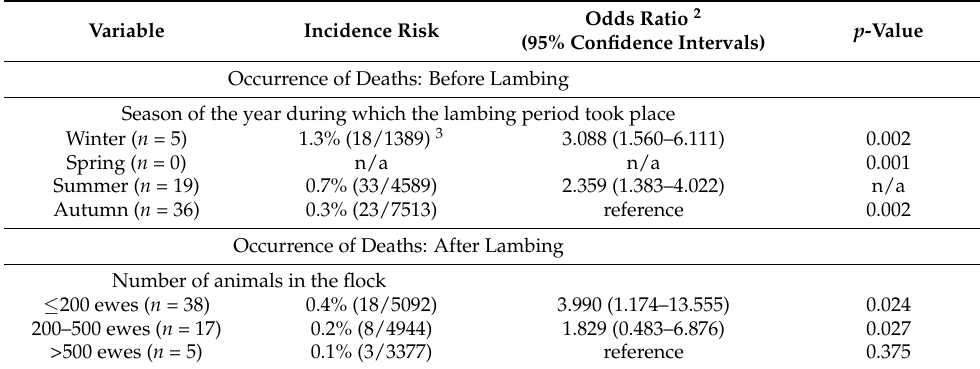
Table 5. Results of multivariable analysis for associations with peri-parturient deaths 1 during a two-year study in 60 sheep flock in